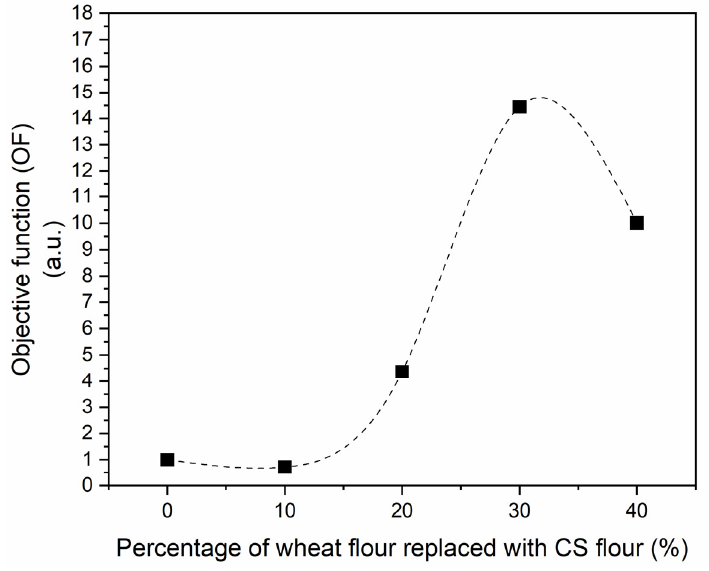
Figure 3. Objective function (OF) in arbitrary units (a.u.) as a function of the percentage of wheat flour replaced with CS flour in cookies: ( ■ ) experimental data; (- - -) spline fitting.